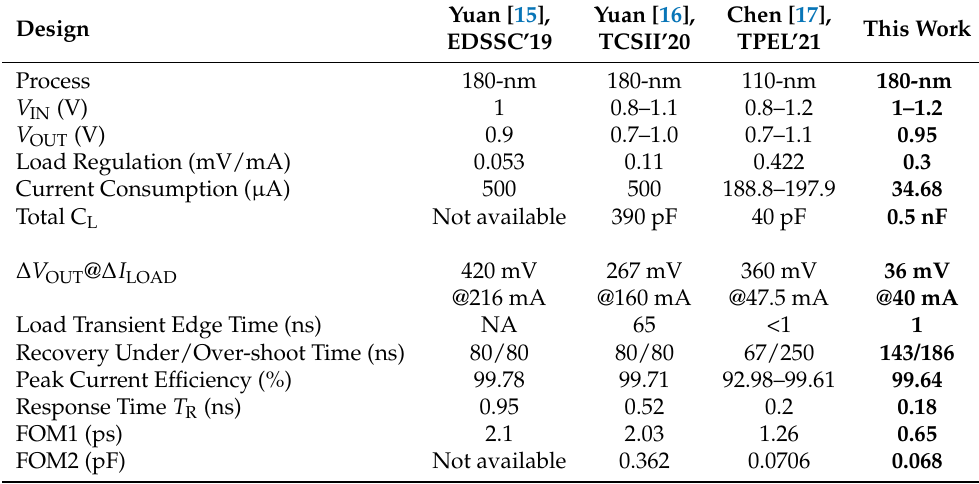
Table 3. Comparison with published D-LDO